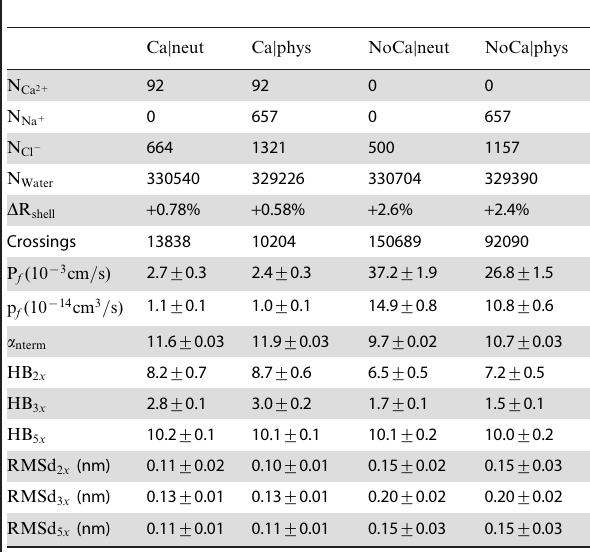
Table 1. System compositions and simulation